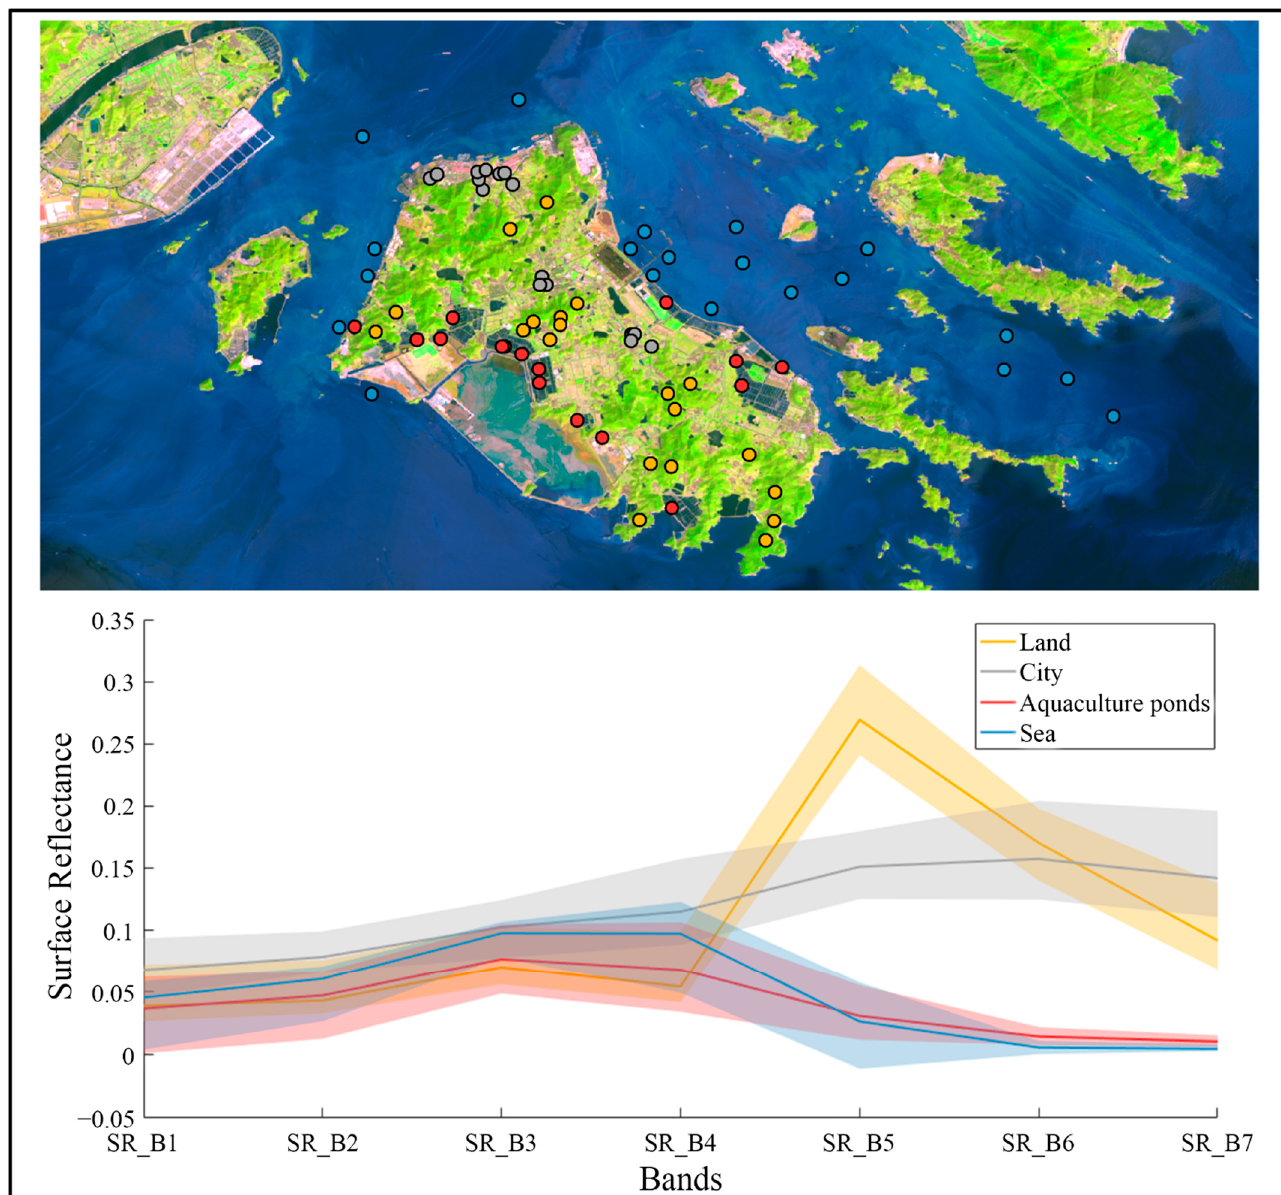
Figure 3. In the top of the picture, we used yellow points, gray points, red points, and blue points to represent land, city, aquaculture pond, and sea type sampling points, respectively. In the bottom plot, we used light-colored regions to roughly represent the distribution of the sampling set and used the solid line to describe the sample median.